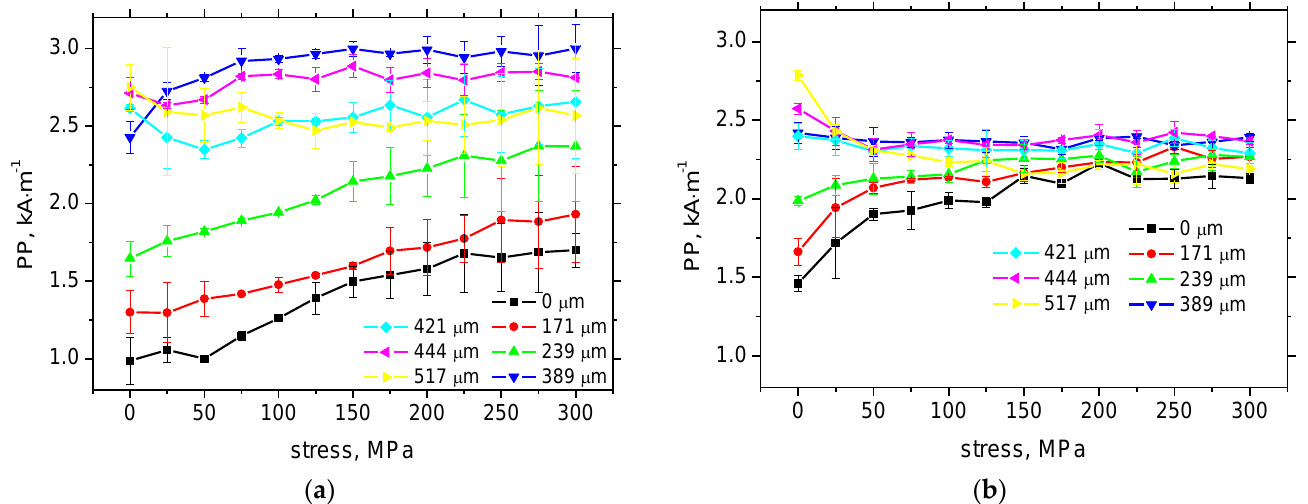
Figure 12. PP versus tensile stress for the different coating thickness. ( a ) RD and ( b ) TD.